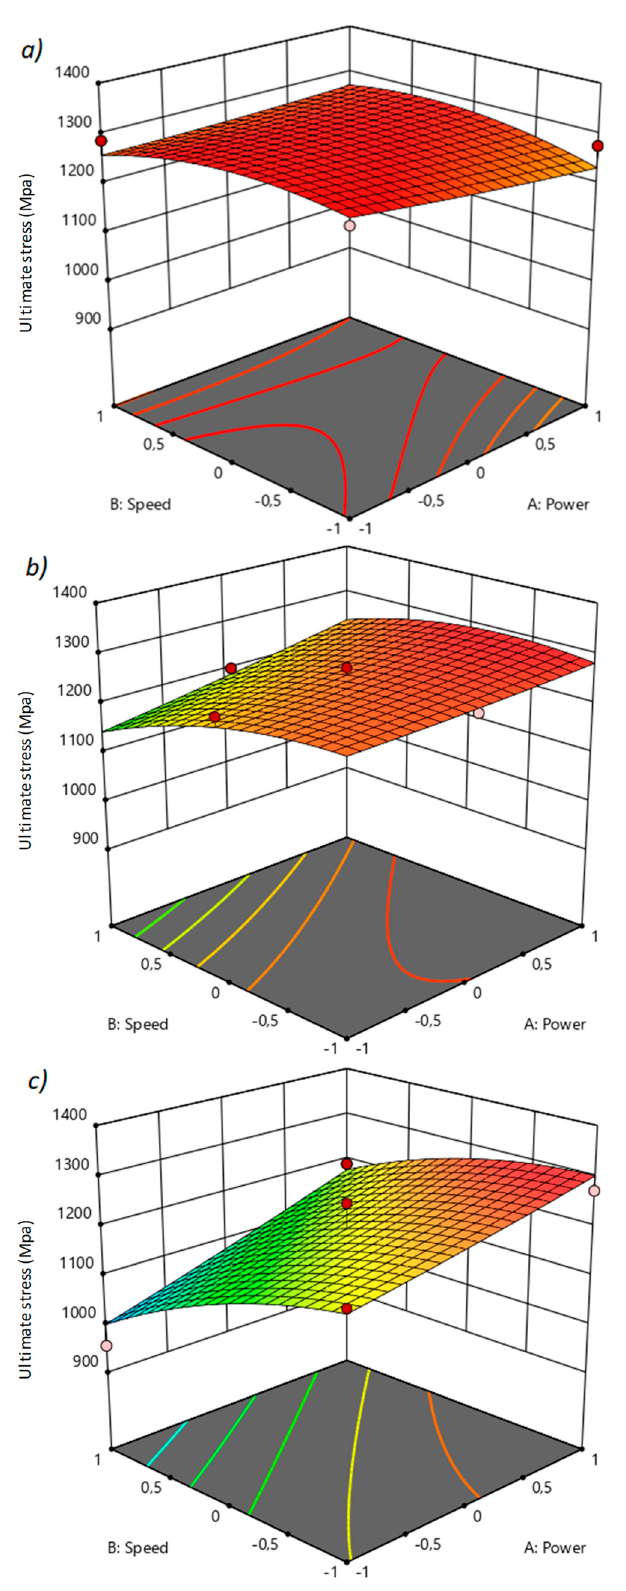
Figure 10. Response surfaces for σ uts , ( a ) H ∗ = − 1 ( b ) H ∗ = 0 ( c ) H ∗ = 1 .